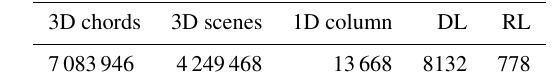
Table 2. Number of chords diagnosed from model output, Doppler lidar (DL), and Raman lidar (RL) observations. There are more chords then scenes in the 3D output because we only require three cloud cells for a chord to be detected but only calculate the scene of the chord if the chord contains at least 10